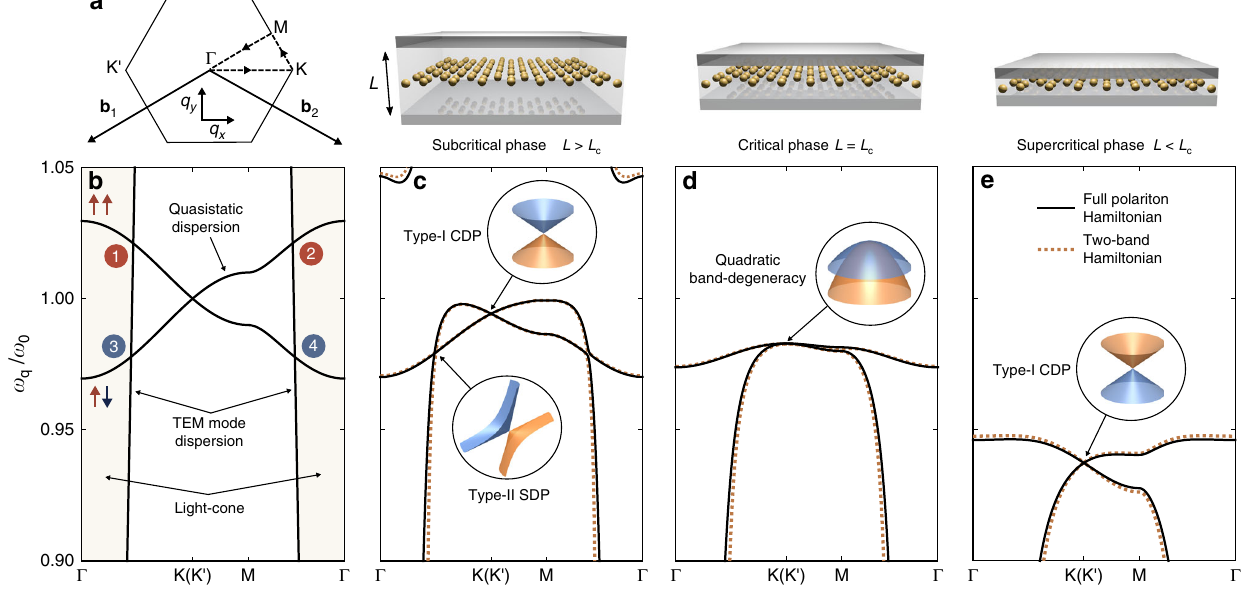
Fig. 2 Evolution of the polariton dispersion as the cavity height is reduced. a First Brillouin zone de fi ned by primitive reciprocal lattice vectors b 1 ¼ ffiffiffi p ffiffiffi p (cid:5) (cid:6) (cid:5) (cid:6) ; (cid:4) 1 (cid:4) ; (cid:4) 1 2 π 3 . b Quasistatic dispersion of the collective-dipole normal modes, where the upper band corresponds to a bright, 3 and b 2 ¼ 2 π 3 a 3 a symmetric dipole con fi guration ( ↑↑ ) and the lower band corresponds to a dark, antisymmetric dipole con fi guration ( ↑↓ ). The light-cone (shaded region) is bounded by the linear dispersion of the TEM mode. Due to the non-trivial winding in the light – matter interaction (see Fig. 3), the band crossings are expected to result in large (band crossings ‘ 1 ’ and ‘ 2 ’ ) or small (band crossings ‘ 3 ’ and ‘ 4 ’ ) direction-dependent anticrossings in the polariton spectrum. c – e Polariton dispersion obtained from the polariton Hamiltonian H pol (solid black lines) and the two-band Hamiltonian H subcritical ( L = 5 a ), d critical ( L = L c = 1.75 a ), and e supercritical ( L = a ) cavity heights, respectively. While type-I CDPs with an isotropic Dirac cone (see inset of c ) exist even in the quasistatic dispersion (see b ), new type-II SDPs with a critically tilted Dirac cone (see inset in c ) emerge due to the vanishing light – matter interaction for the dark quasistatic band along the Γ − K(K ′ ) directions (see Fig. 3). At the critical cavity height L c , three type-II SDPs merge with the type-I CDP (see Fig. 5) resulting in a quadratic band-degeneracy at K(K ′ ) (see inset in d ). After criticality, the type-II SDPs annihilate one another and the massless Dirac cone re-emerges at the type-I CDPs (see inset in e ) accompanied by an inversion of chirality (see Fig. 5). Plots obtained with ¼ 2 : 5 ω Ω = 0.01 ω parameters ω ph 0 and K0